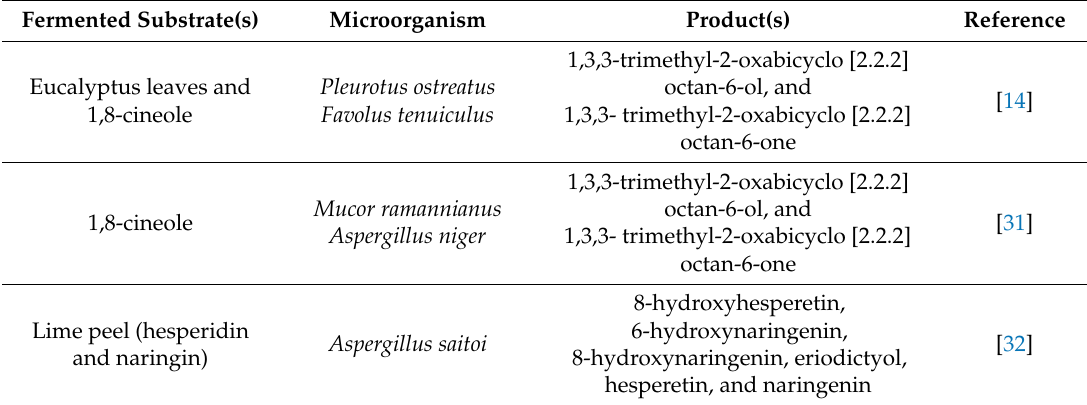
Table 1. Bioactive products obtained through fermentation of agro-industrial wastes or by-products by di ff erent